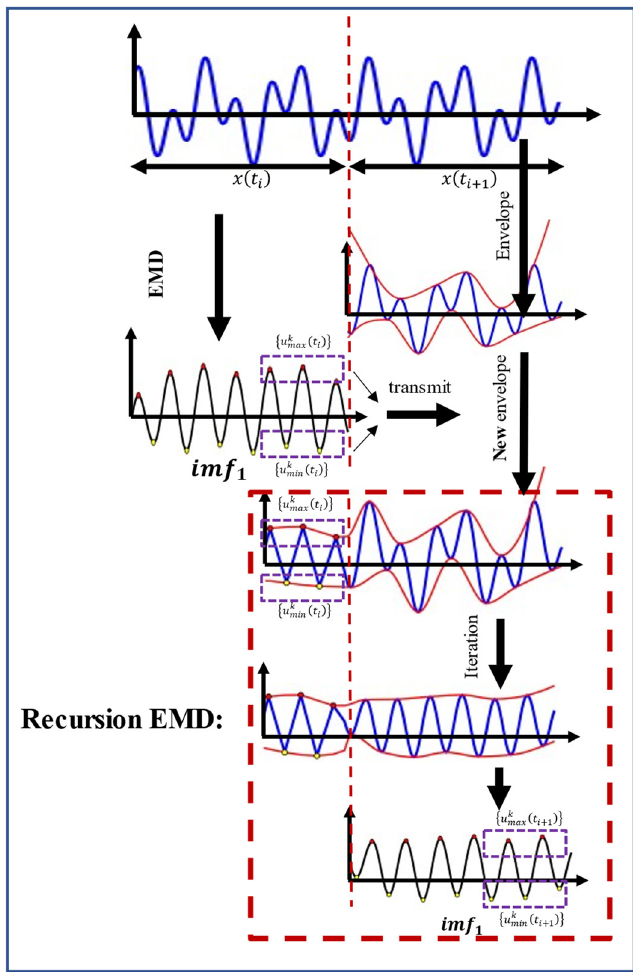
Figure 2. Flow chart of recursion EMD.